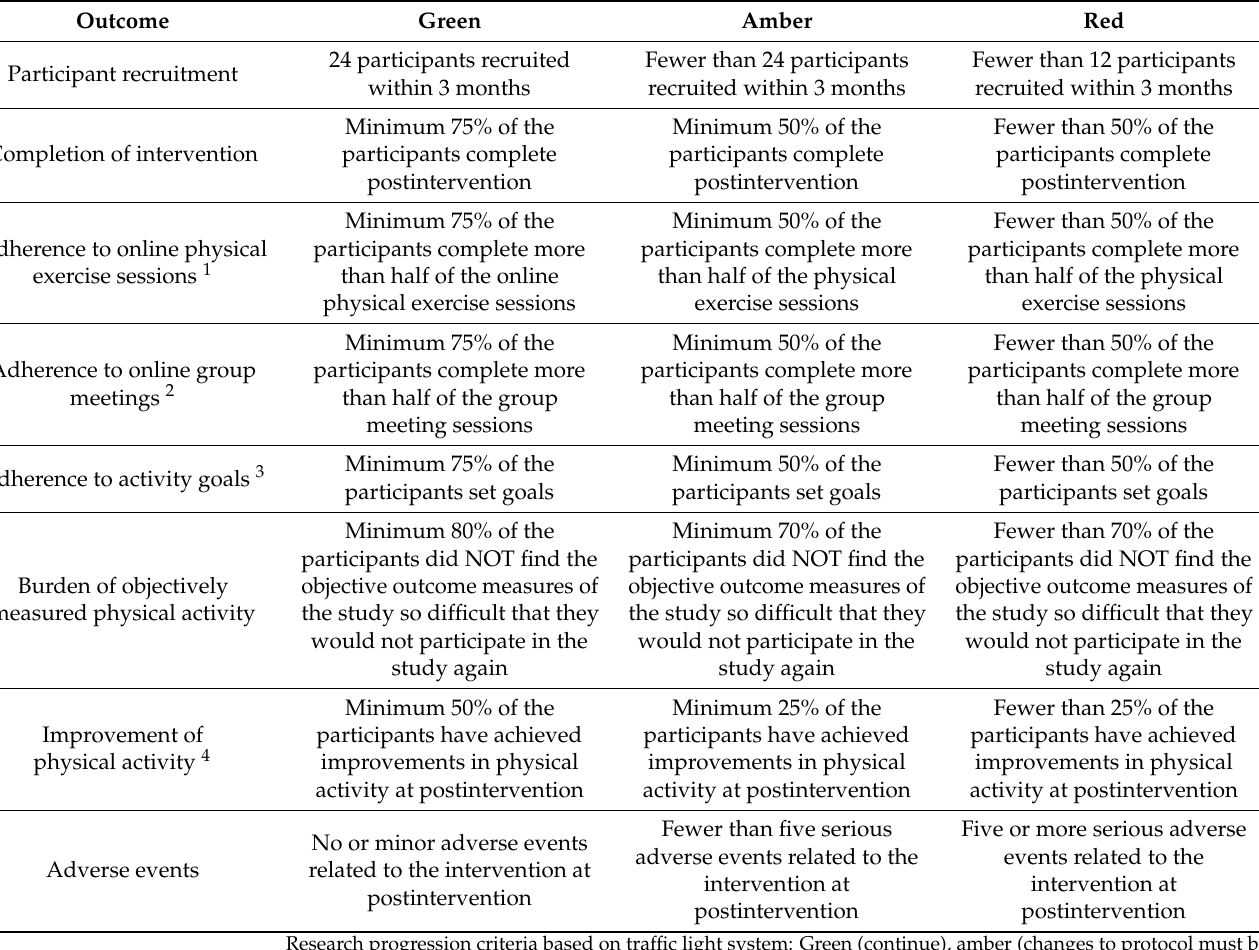
Table 1. Research progression criteria for continuing to definitive